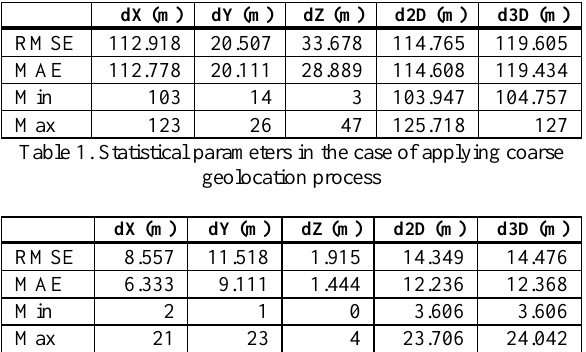
Table 2. Statistical parameters in the case of applying fine geolocation